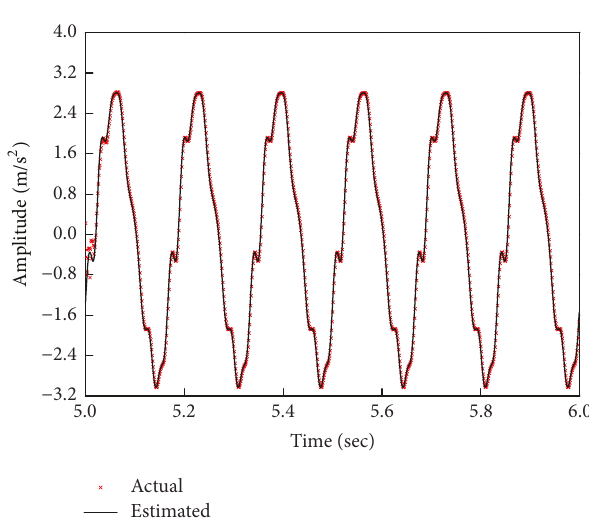
on estimated parameters matches the actual signal very well. This demonstrates that the proposed method can precisely estimate the harmonic